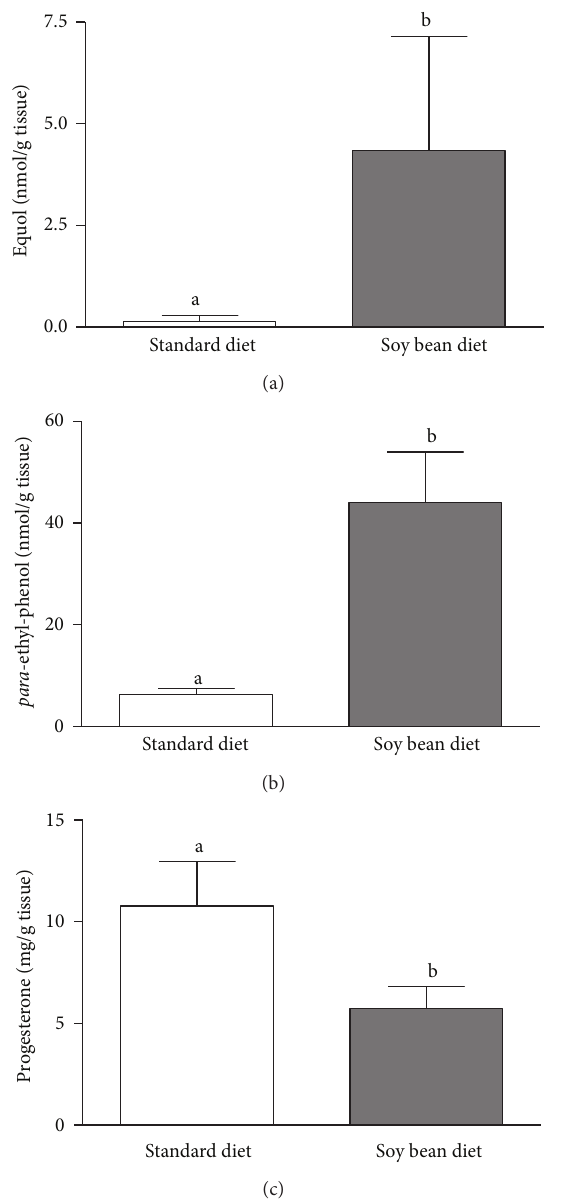
Figure 4: Concentrations of equol (a), para -ethyl-phenol (b), and progesterone (c) in the corpus luteum tissue of cows fed with soy diet (grey bars; 2.5 kg soy bean/animal/day) or with standard diet (white bars) (adapted from Piotrowska et al., 2008).